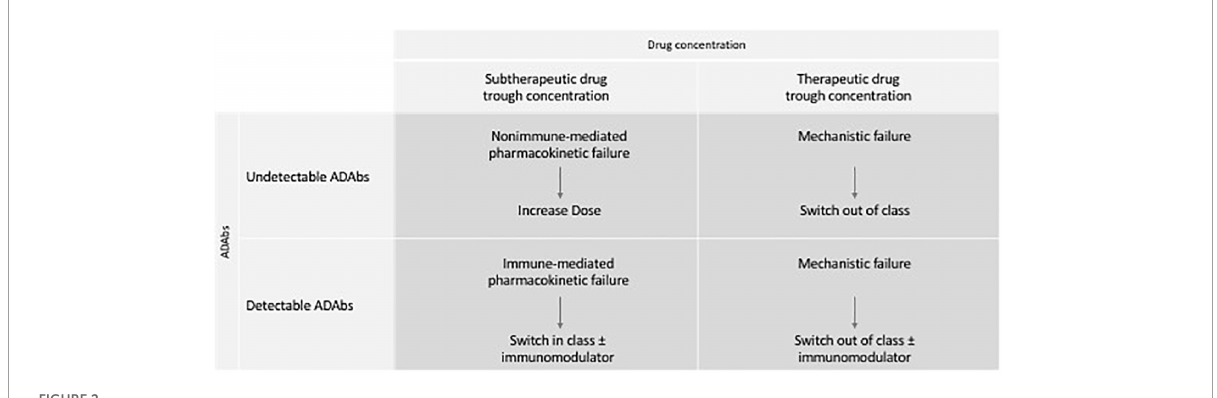
FIGURE2 Approach of secondary loss of response of reactive TDM.